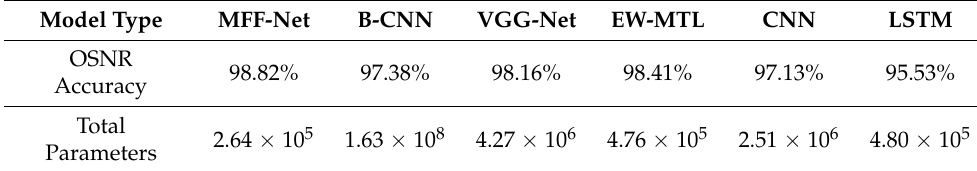
Table 1. Comparison of different